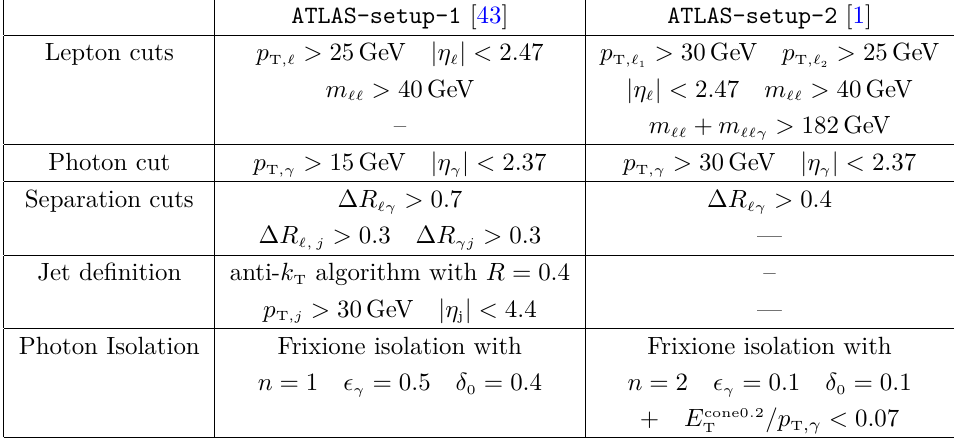
Table 1. Fiducial cuts in two different ATLAS setups denoted as ATLAS-setup-1 and ATLAS- -setup-2 . See text for